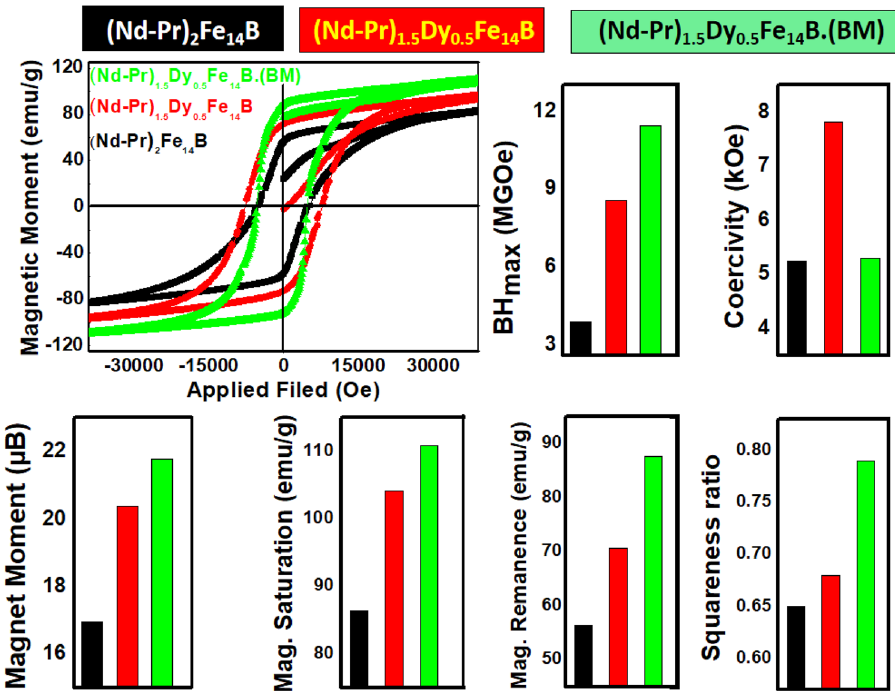
Figure 4. Magnetic hysteresis loop and comparison of magnetic properties of (Nd–Pr) 2 Fe 14 B, (Nd–